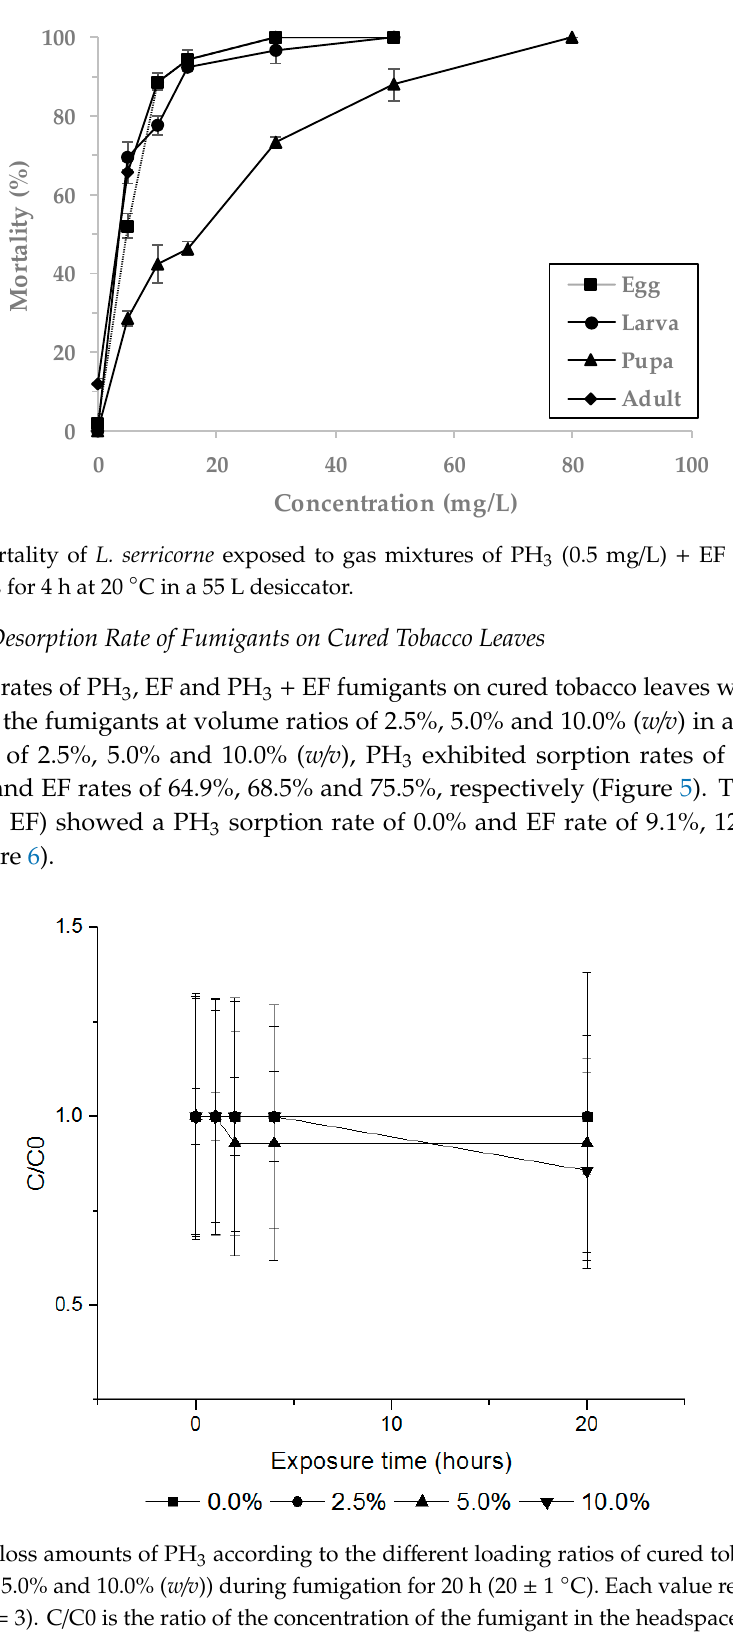
Figure 5. The amount of EF loss according to the different loading ratios of cured tobacco leaves (control, 2.5%, 5.0% and 10.0% ( w/v )). Each value represents the mean ± SE ( n = 3). C/C0 is the ratio of the concentration of the fumigant in the headspace.